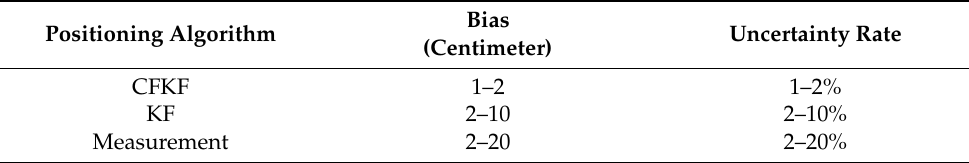
Figure 13. Zoomed comparison of different algorithm results in the UWB field experiment. Table 4. Algorithm bias table for field